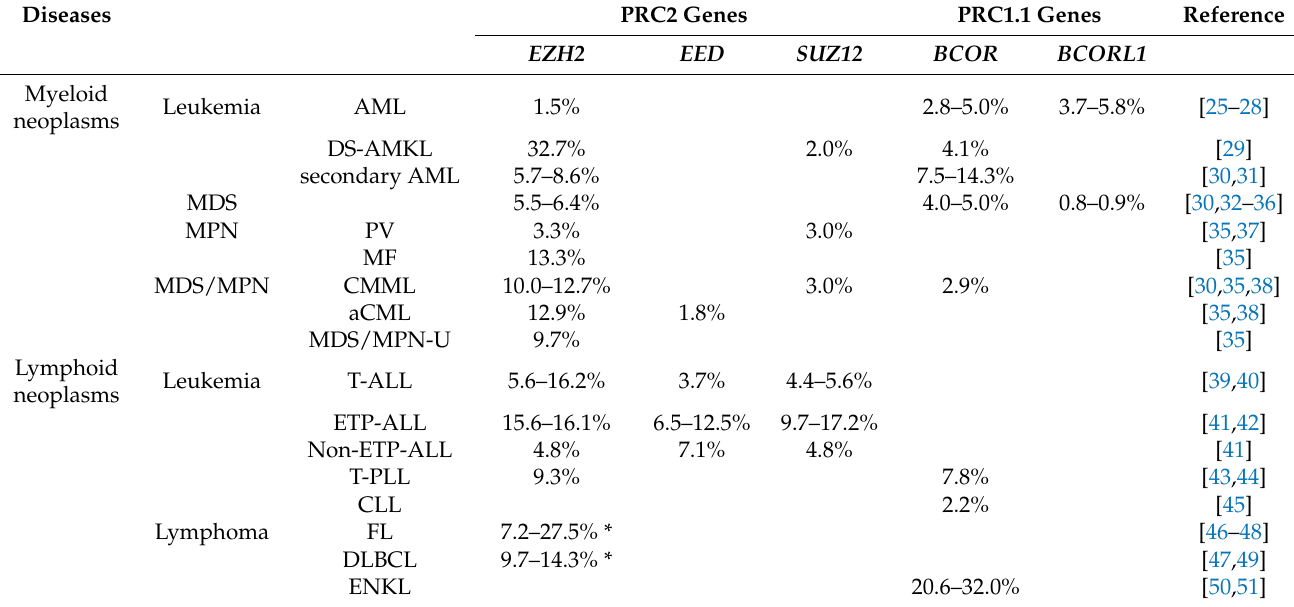
Table 1. Frequencies of mutations in PRC genes in hematologic